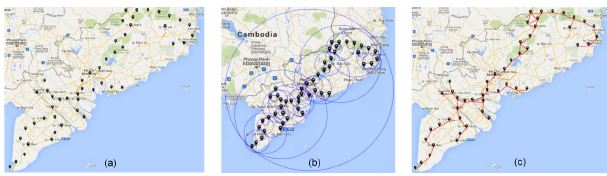
Figure 8. Verify dynamicsensornetworkconnectivity.(a) A 50- nodedynamicsensornetwork,(b) Balltree structureof the DSF, (c) Connectivityof the DSF.